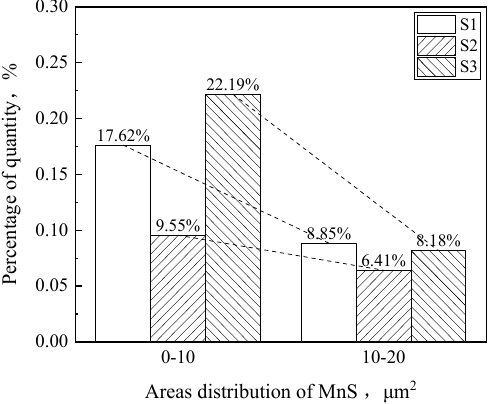
Figure 14. Proportion of spindle–shaped sulfides in MnS with different area sizes.